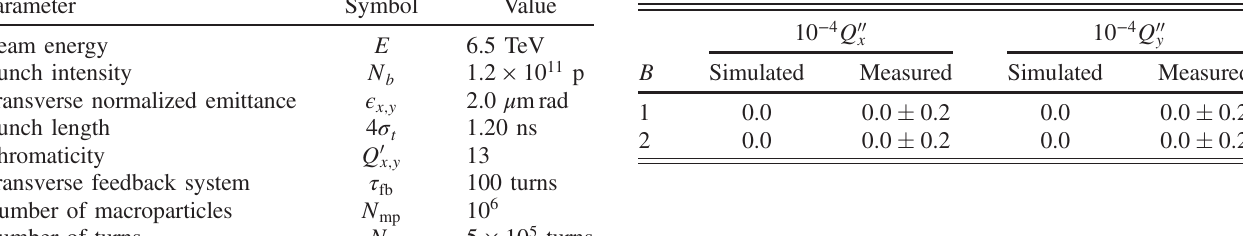
Table II. The contribution from the Landau octupoles to the Q 00